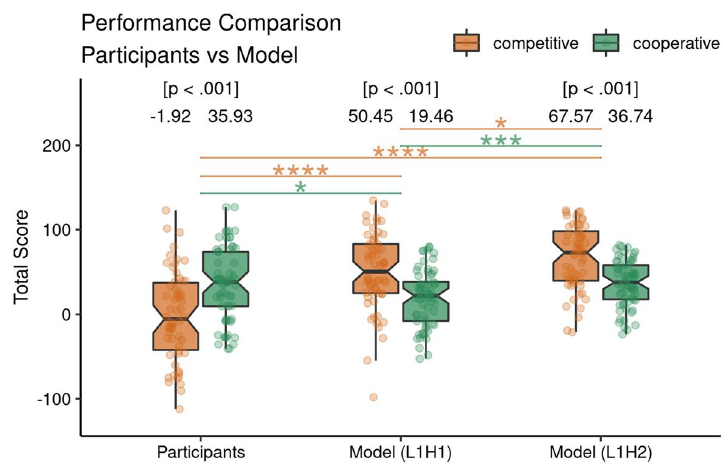
Figure 7. Comparison of performance of the participants with the models during the multiagent version of the ITT in competitive and cooperative contexts. The figure shows the points obtained (respective means above the box-plot) by the participants and the L1H1 and L1H2 optimal I-POMDP models. The points are individual participants in the respective contexts, while the p values demonstrating significance is above the